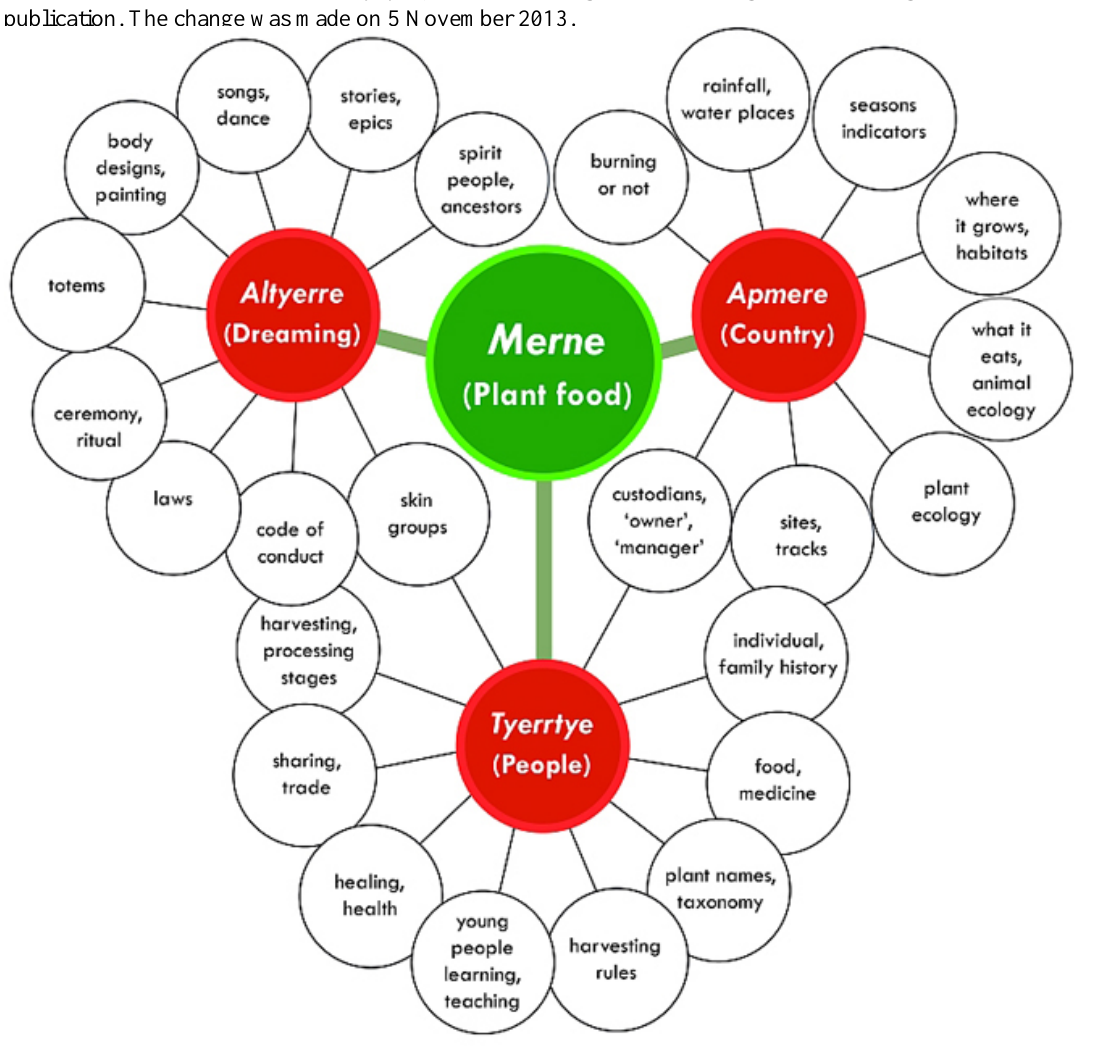
Fig. 2 . The Anpernirrentye framework with the major domains (large circles) and associated elements or values of the plant species (small circles). These elements are equivalent to cultural values inherent in a plant species. There are many and complex interrelationships between a bush food species, Dreaming, country, and people. Thus, species have multiple connected values. Erratum: In the PDF version of this paper, the format of figure 2 was changed after the original publication. The change was made on 5 November